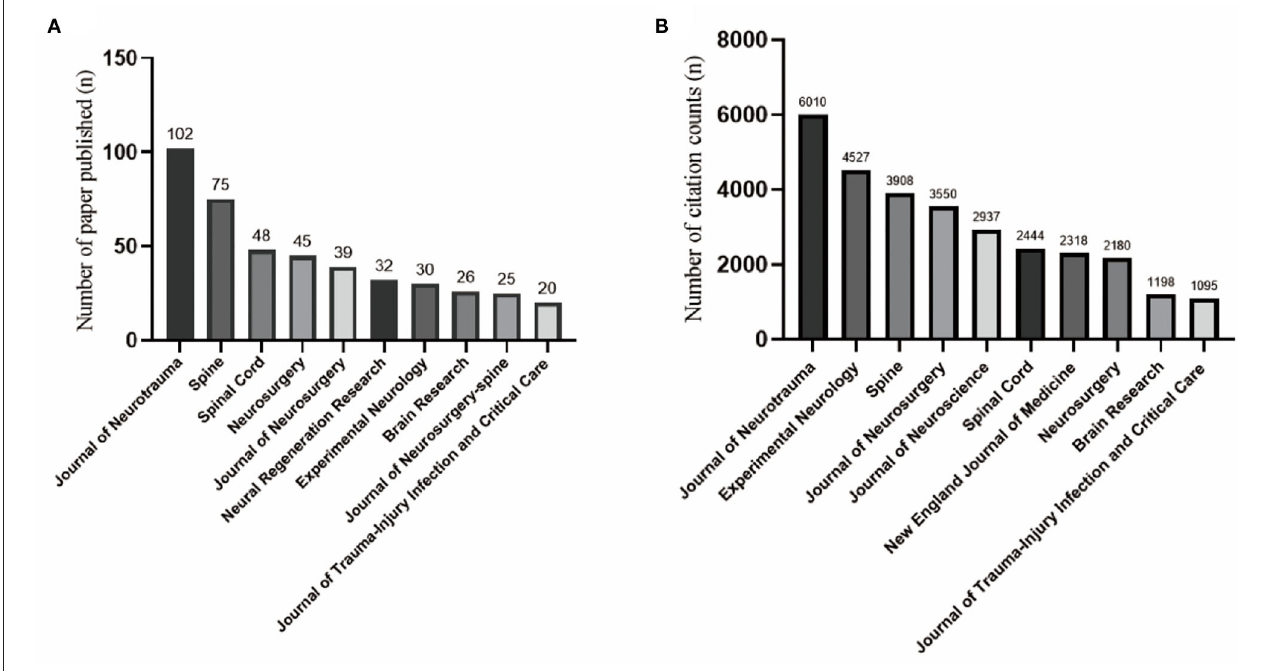
FIGURE 3 | (A) Histogram of the top ten most-cited journals in the field of spinal cord injury and glucocorticoids, with journals of neurotrauma, spine, and spinal cord in the top three. (B) Top ten most published journals, with Journal of Neurotrauma having far more articles than any other nine journals, reaching